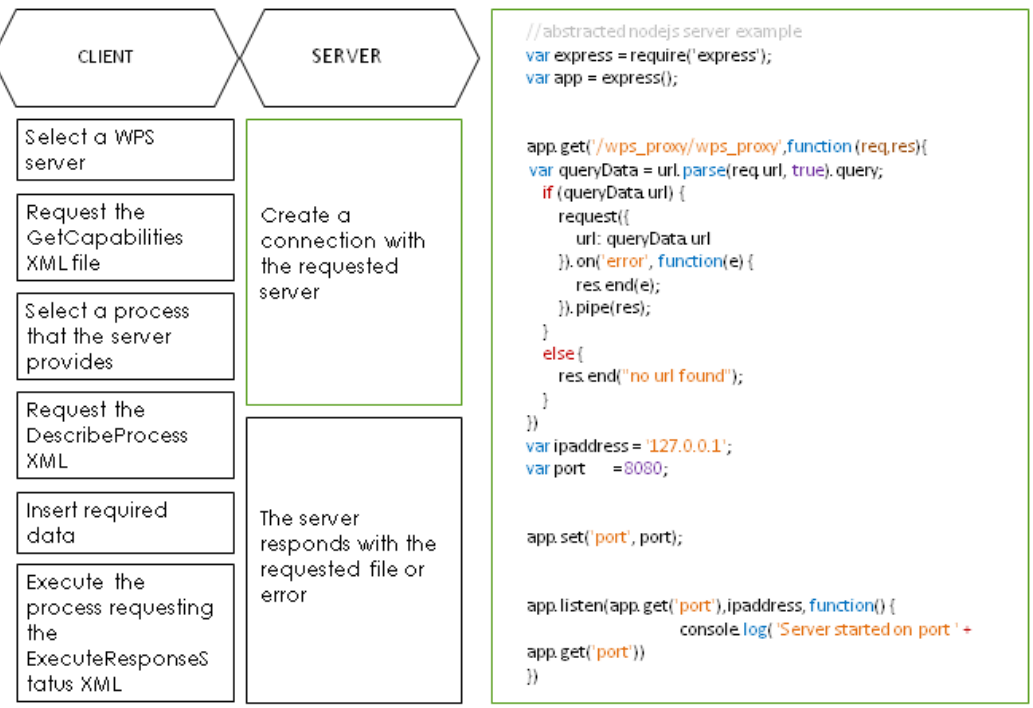
Figure 3. Utilizing Node.js as a Proxy server to achieve cross-origin connections with Open Geospatial Consortium (OGC) implementations.